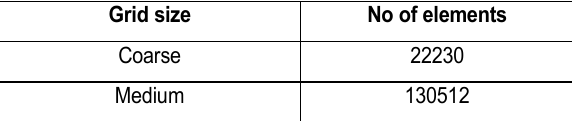
Table 2. Details of grids used in